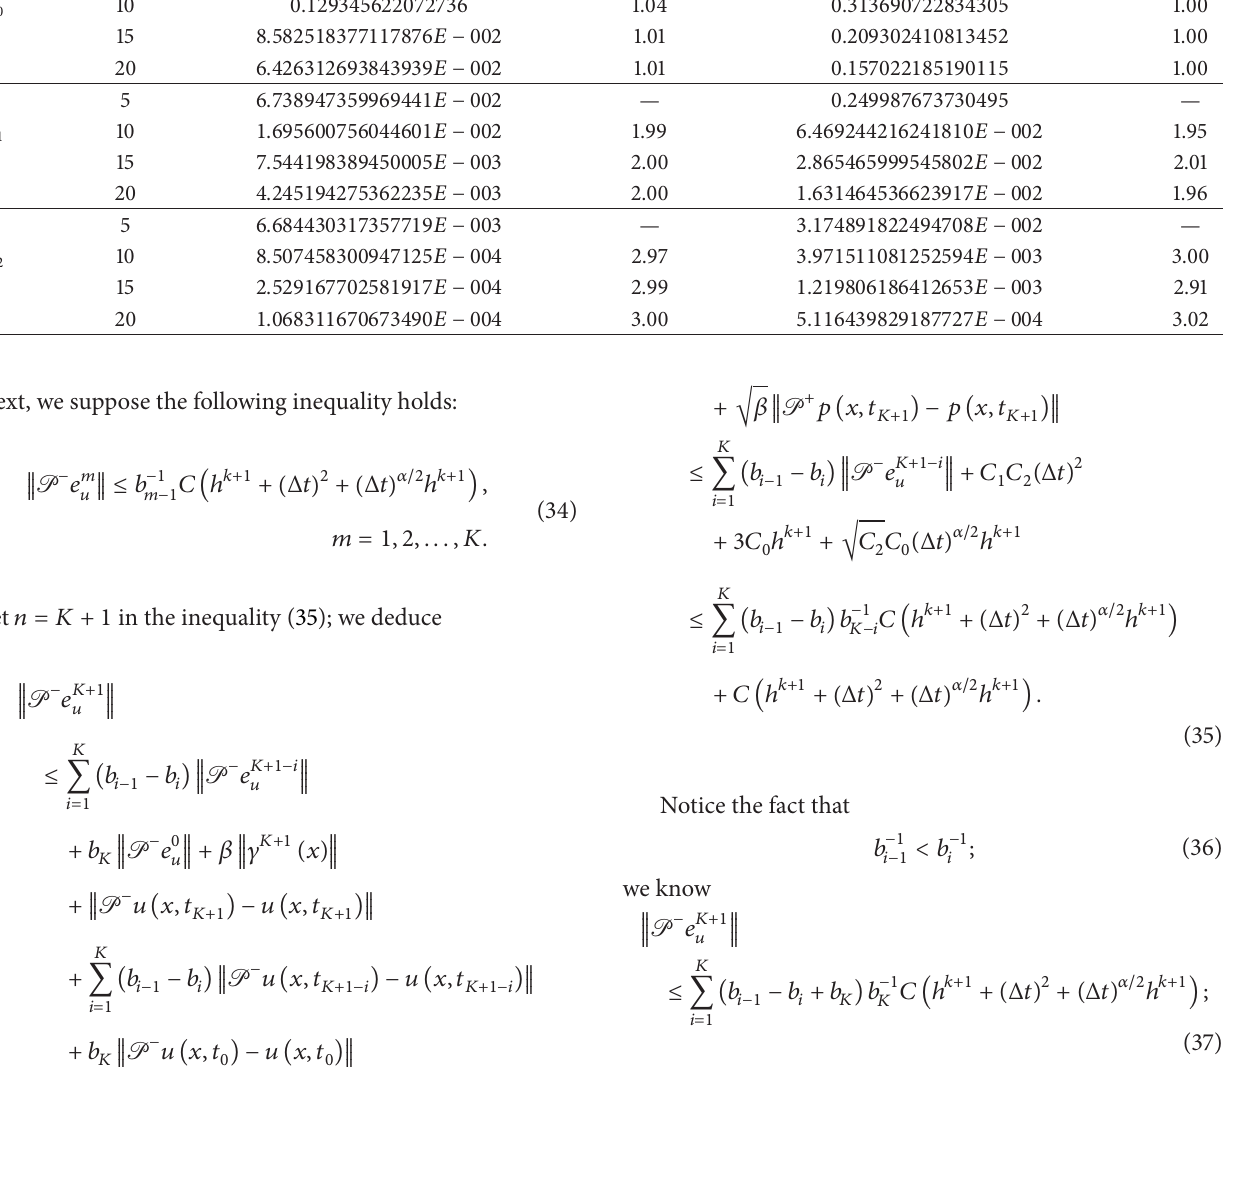
Table 8: Spatial accuracy test for the fractional order equation with the forcing term (42). 𝛼 = 0.8 , 𝑀 = 10 4 , 𝑇 = 1 . 𝑁 𝐿 2 -Error Order 𝐿 ∞ -Error Order 𝑃 0